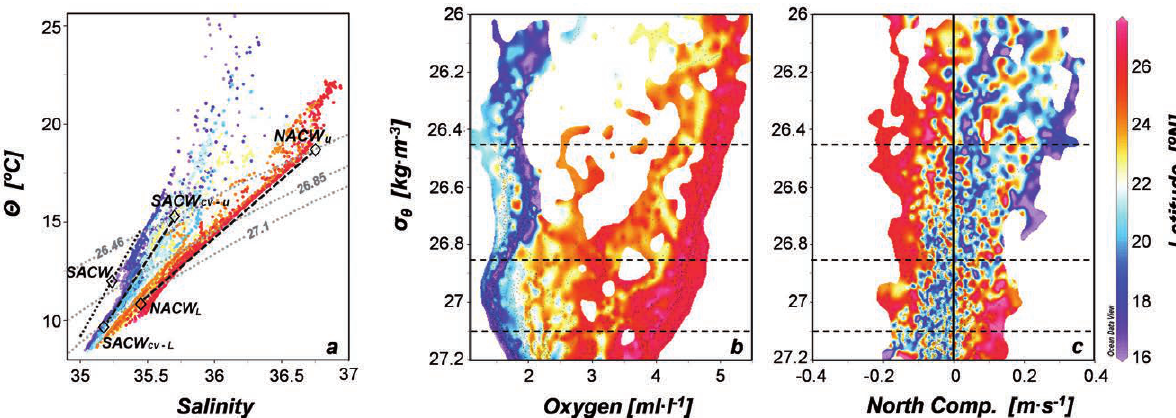
F ig . 3. – Left panel. Potential temperature-salinity diagram as obtained using the whole data set. Void diamonds indicates the water types used in the OMP analysis of Pastor et al. (2011). Central and right panels: Smoothed scatter plots, again obtained using the whole data set, of dissolved oxygen and meridional velocity (in [m s –1 ], positive northwards) as a function of potential density. In all plots the latitude [°N] is colour-coded according to the right-hand-side colour